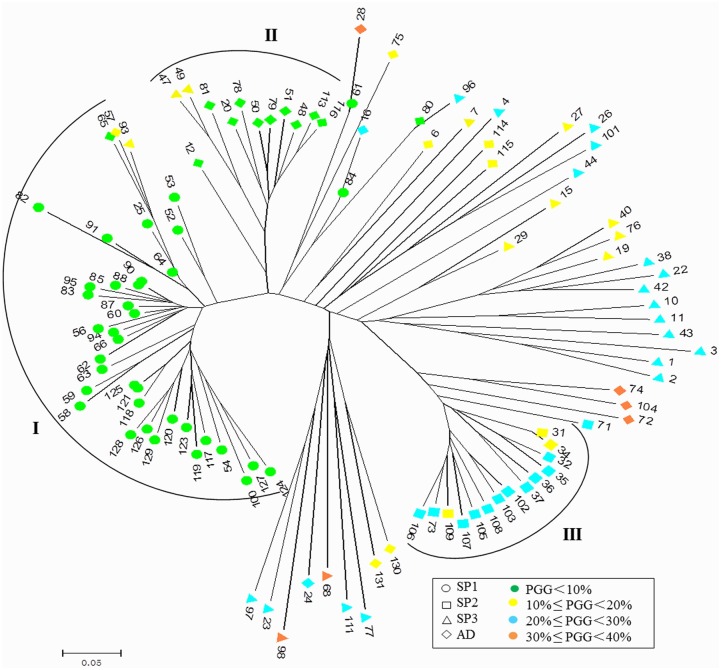
Unrooted neighbor-joining phylogenetic trees based on AFLP markers in the ILs.There were 35 and 10 ILs with lower PGG (< 10%) in Cluster I (37) and Cluster II (12), respectively. while Cluster III contained 14 ILs with intermediate PGG (10% − 30%). The remaining 44 ILs with intermediate or higher PGG were scattered in different clades.